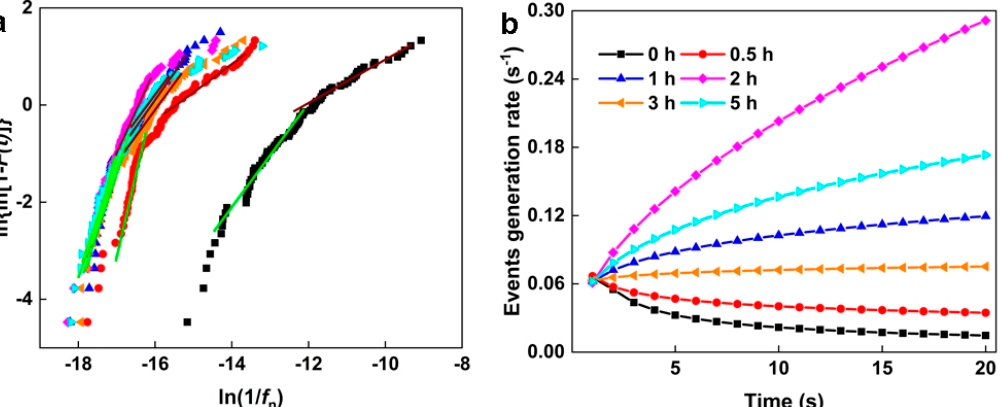
Figure 9. ( a ) Weibull distribution of f n of NAB after different CE times: ( b ) Plots of the incubation rate of selective phase corrosion after different CE times.